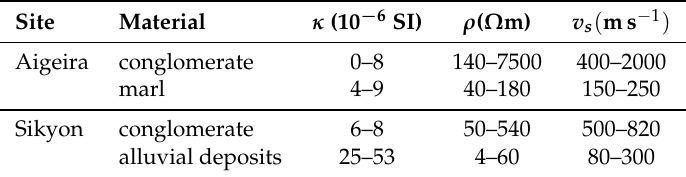
Table 2. Summary of all physical properties derived from the geophysical measurements from Aigeira and Sikyon. κ , magnetic susceptibility; ρ , specific electrical resistivity; v s , seismic shear-wave